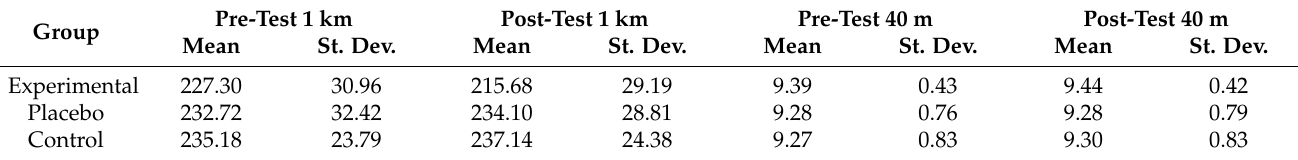
Table 2. Results of 1 km and 40 m shuttle run in seconds.